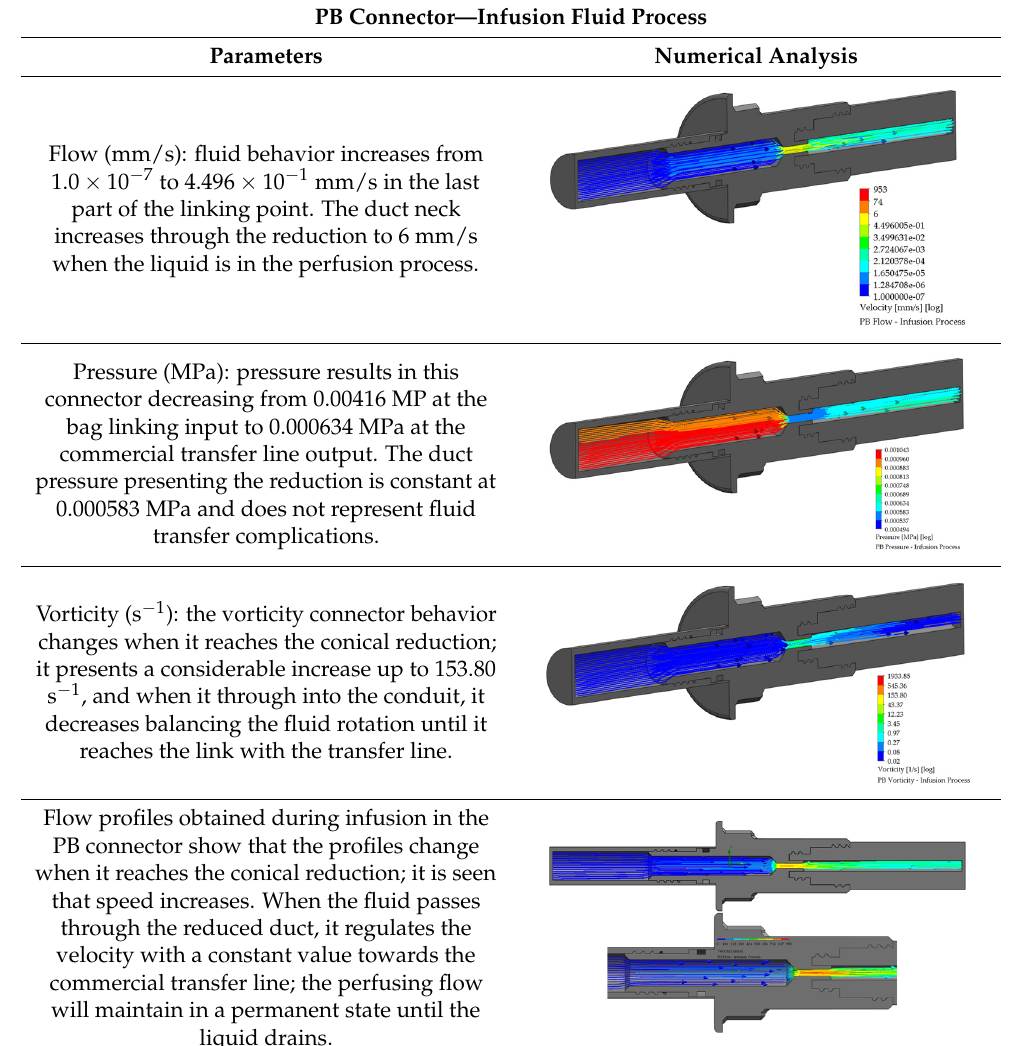
Table 5. Flow, pressure, and vorticity numerical analysis for PB connector—infusion fluid process.